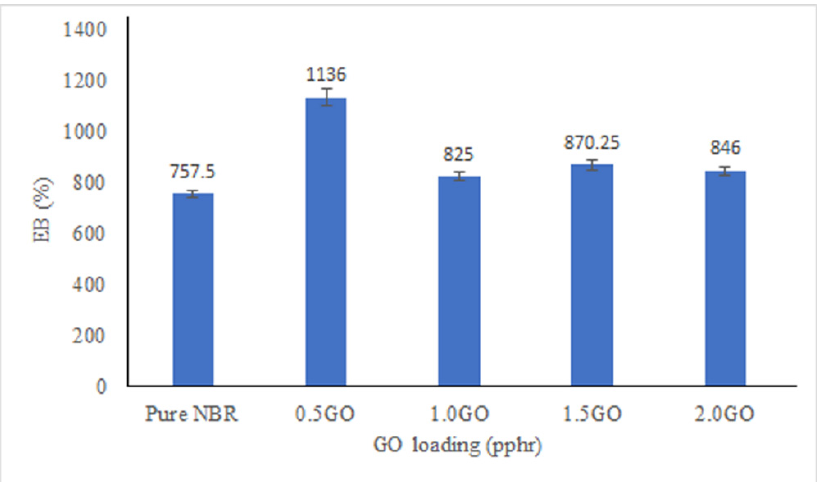
Figure 6. Elongation at break of the membranes at different GO loading.